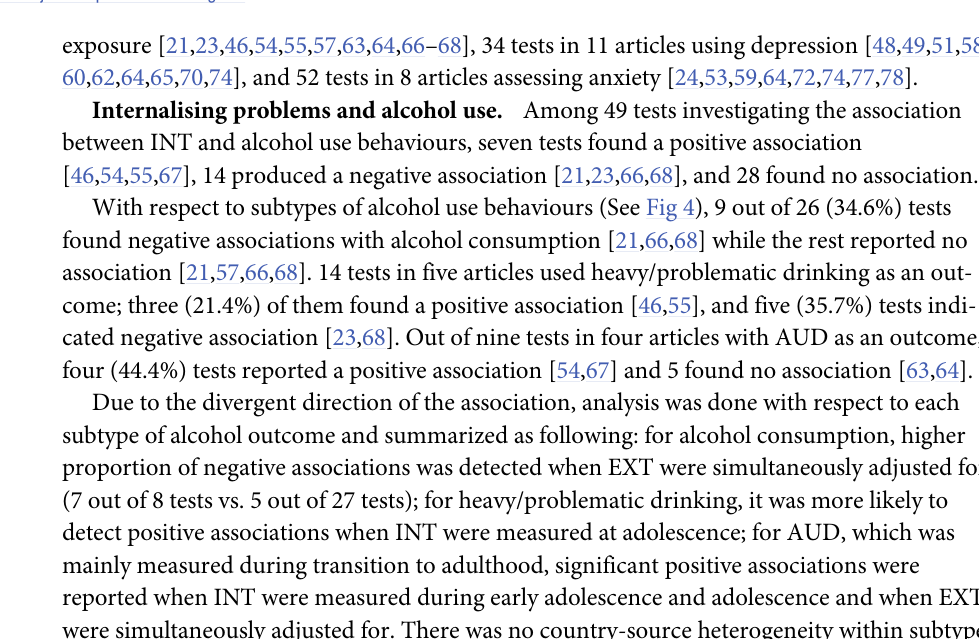
Fig 5. Distribution of association tests between depression and subtypes of alcohol use behaviours. Distribution of association tests clustering in one article was plotted on the left to show the non-independence among tests.